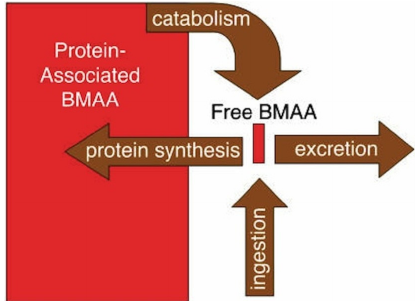
Figure 1. Schematic representation of the endogenous neurotoxic reservoir of Beta- N -methylamino- L -alanine (BMAA) that slowly and continuously releases the neurotoxin into cerebral tissue through protein metabolism (Source: Murch et al.